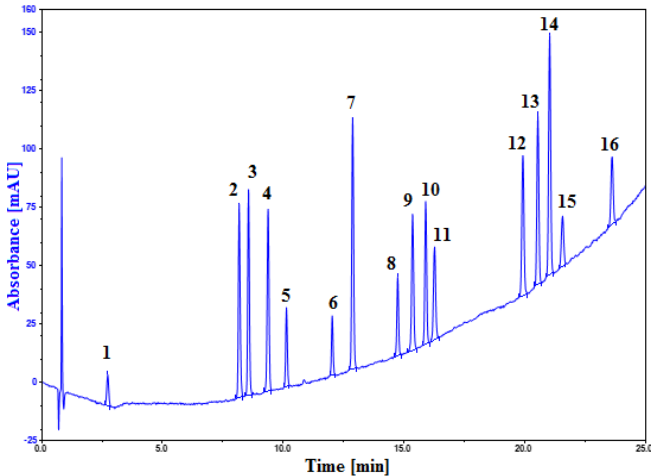
Figure 3. Separation of 16 active pharmaceutical ingredients. Xbridge BEH Shield RP18 column (50 × 4.6 mm i.d., 2.5 μ m). Gradient elution of ethanol from 5% to 80% (slope of 2.57%/min) with acetate buffer 20 mM at pH 4.85. Flow rate: 0.8 mL/min. Temperature: 33.7 °C. Detection at 210 nm. Peak